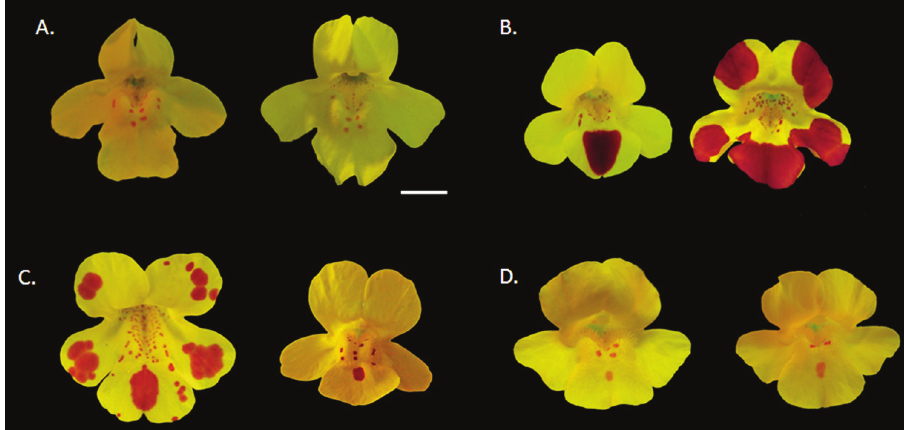
Figure 2. Flowers of M. peregrinus and closely related taxa. A M. guttatus B M. × smithii ( M. luteus luteus × M. luteus variegatus ) C M. × robertsii ( M. guttatus × M. luteus ), and D M. peregrinus . Each taxon is represented by flowers from two individuals from a single locality to illustrate within-population vari- ability: M. guttatus = Dunblane, Perthshire; M. × smithii = Coldstream, Scottish Borders; M. × robertsii = Nenthall, Cumbria; M. peregrinus = Leadhills, South Lanarkshire. Scale bar =